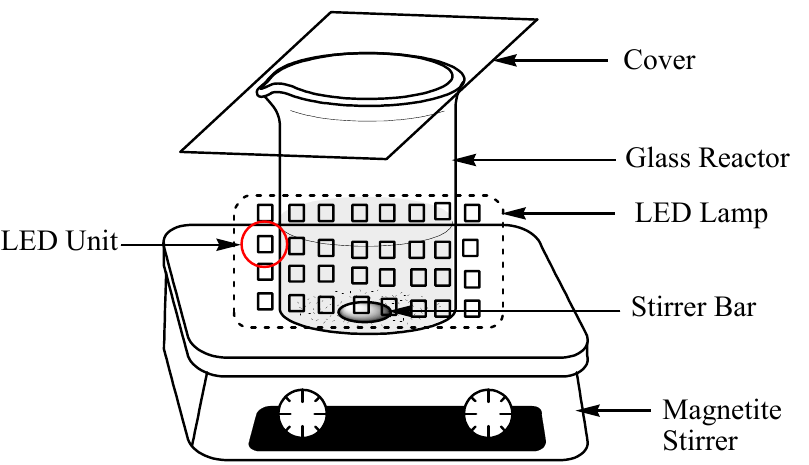
Figure 1. Scheme of the experimental reaction con fi guration with a LED strip as light source.